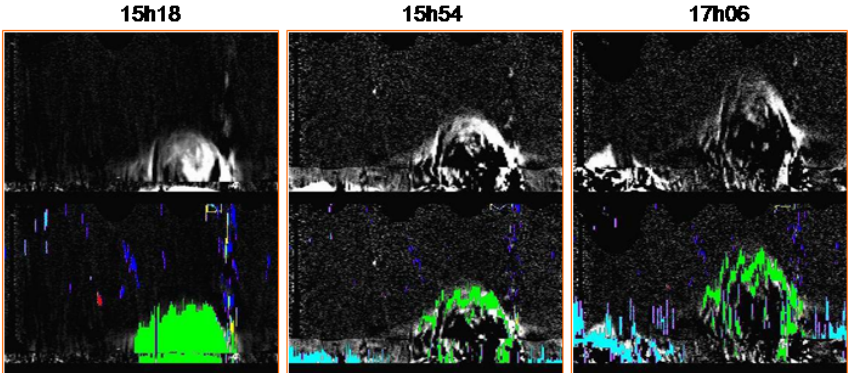
Fig. 4. A sequence of 3 running difference polar images is shown (top row), containing 2 CMEs on 11 November 2003. The bottom row shows the CME detections by CACTus (from Robbrecht and Berghmans, 2004). The method is very successful, 96% of all CMEs detected by human operators were recovered (based on a data-set of 6 days in November 2003). However, the method also found many more events. Some of these were genuine CMEs missed by the operators, but in most cases the software discovered features that the operators disregarded for various reasons although they fulfill the formal definition (outward moving bright features). These include events that were felt to be too small or too narrow (called spikes, surges) or too much alike the background wind (called gusty outflow).